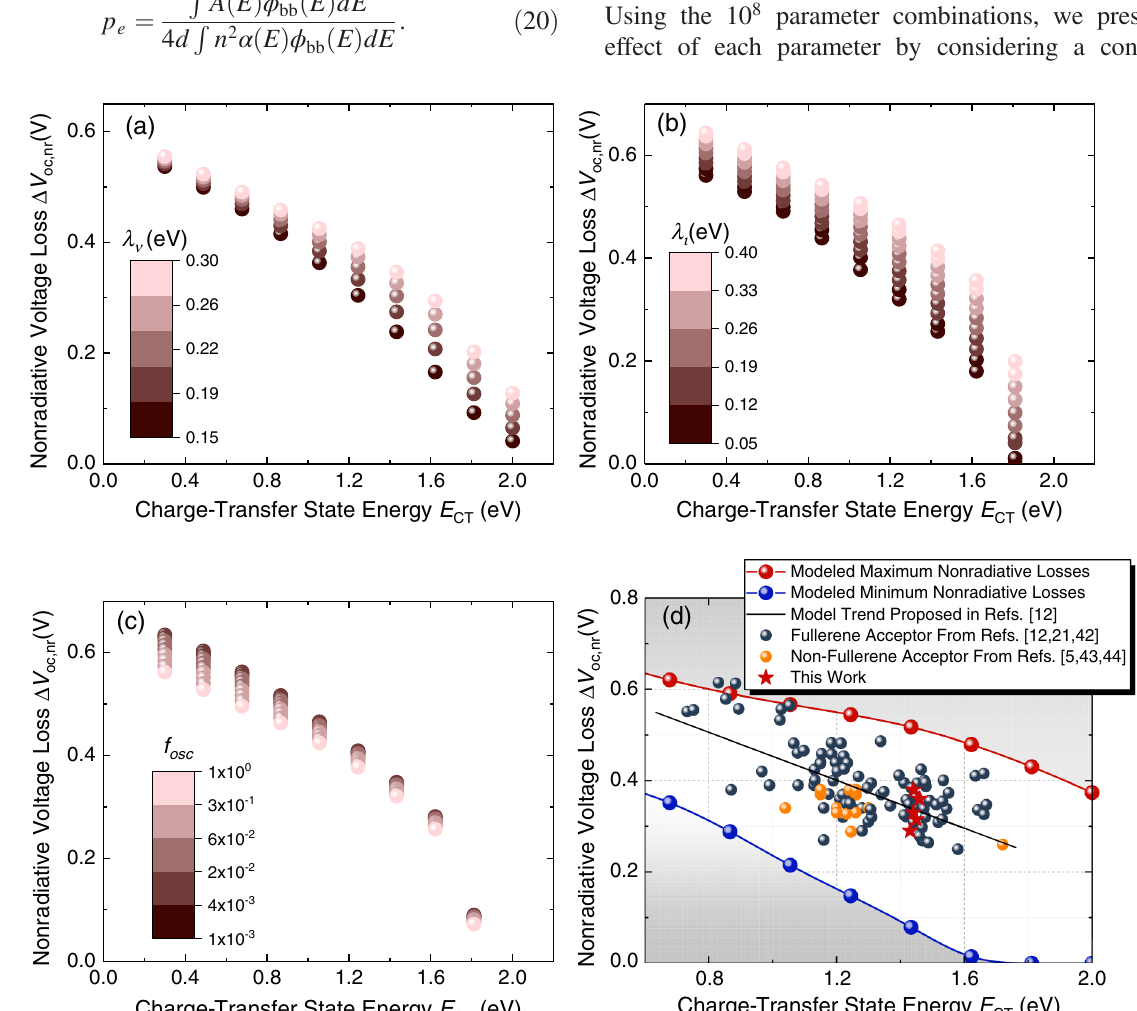
FIG. 2. Nonradiative voltage loss as a function of the energy of the charge-transfer state with respect to changed (a) high-frequency reorganization energy λ , (b) low-frequency reorganization energy λ , and (c) oscillator strength f . (d) Predicted maximum (red line) v l osc and minimum (blue line) nonradiative voltage losses Δ V as a function of the energy of charge-transfer state E obtained using the oc ; nr CT proposed model sampling a range of values for each of the six parameters. The key parameters for modeling the “ maximum ” and 0 . 32 eV, λ 0 . 4 eV, f 4 × 10 − 3 and λ 0 . 15 eV, λ 0 . 05 eV, f 4 × 10 − 1 , respectively. For “ minimum ” cases are λ v ¼ l ¼ v ¼ l ¼ osc ¼ osc ¼ comparison, a variety of reported experimental values from the literature are shown (circular symbols) [5,12,21,42 – 44]. The data labeled “ this work ” is obtained from BIT- 4 F ∶ PC 71 BM devices in the experimental section. A complicated version of (d) specifying the references can be found in Fig. S1